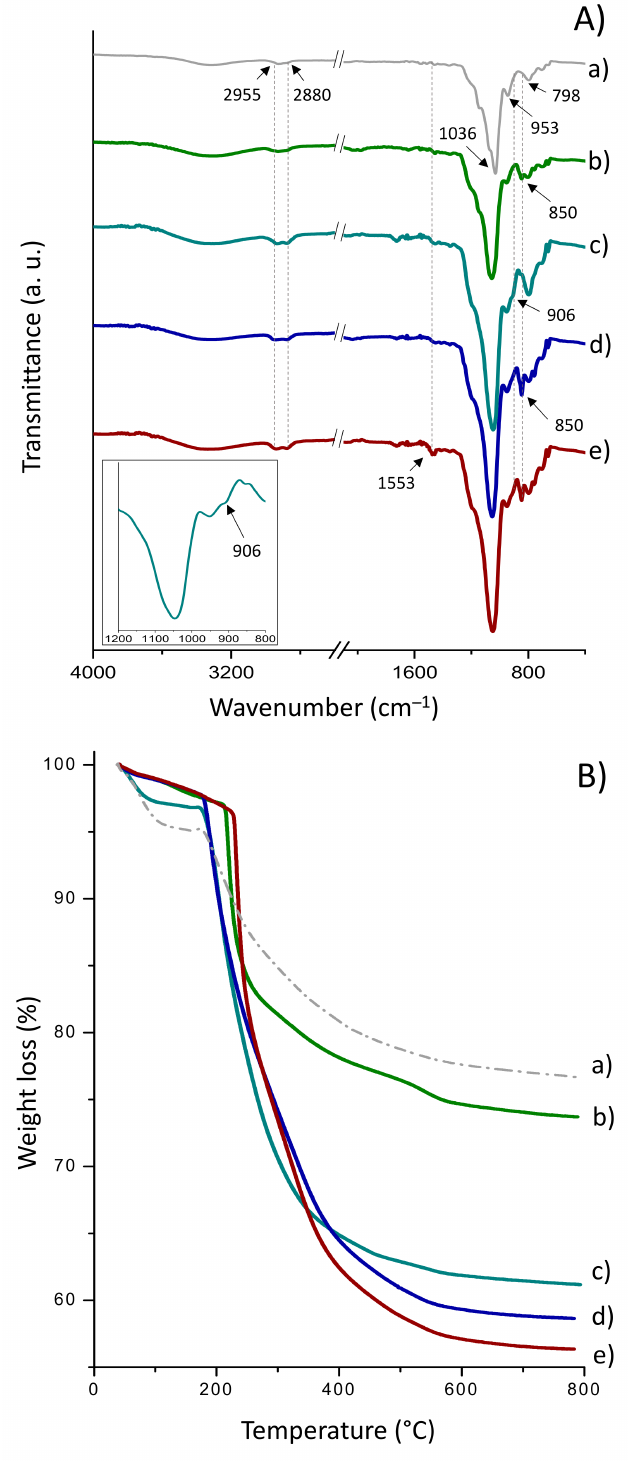
Figure 3. ATR FTIR spectra ( A ) and TG curves ( B ) for ( a ) as-synthesized Sihgel, ( b ) Sihgel@CTMS, intensity of the band at 906 cm − 1 suggests that part of epoxy groups may have been opened into diols during reaction with surface